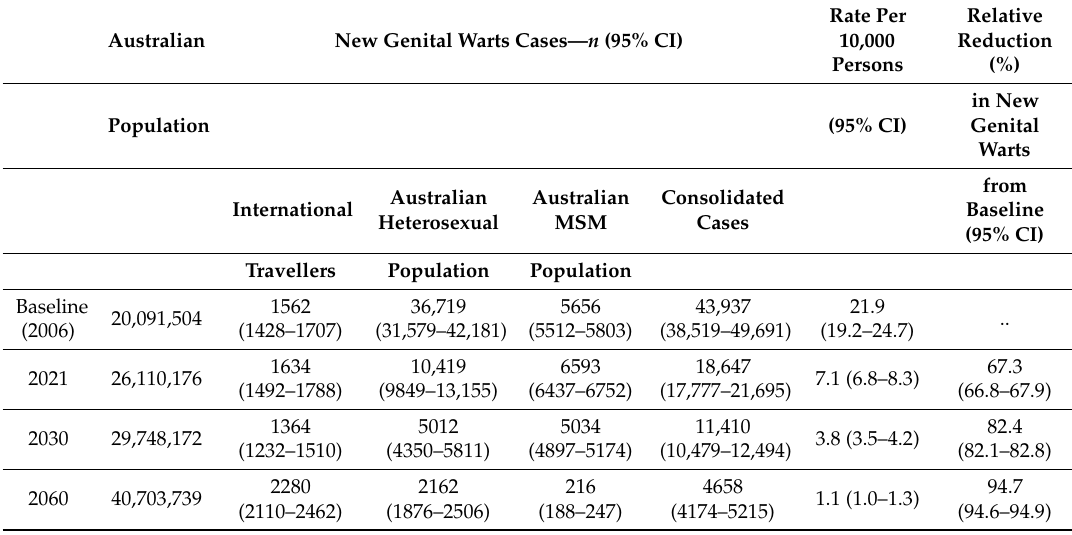
Table 1. Estimates presented at the Delphi workshop for number and relative reduction in new genital warts cases in Australia (consolidated cases including Australian residents and international